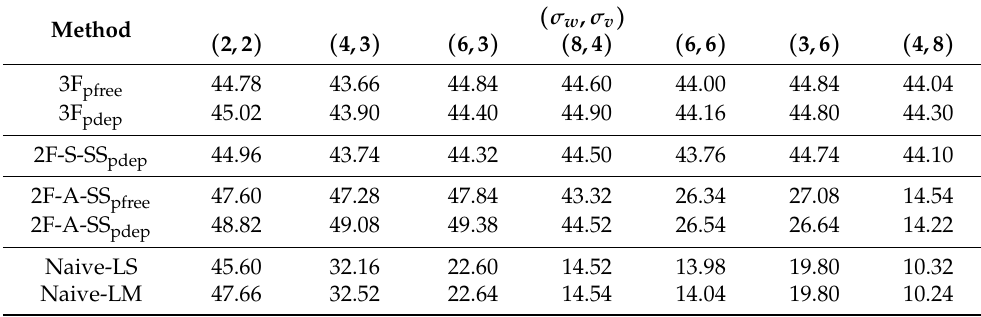
Table 3. True model selection rate (%): Mallows’ C p